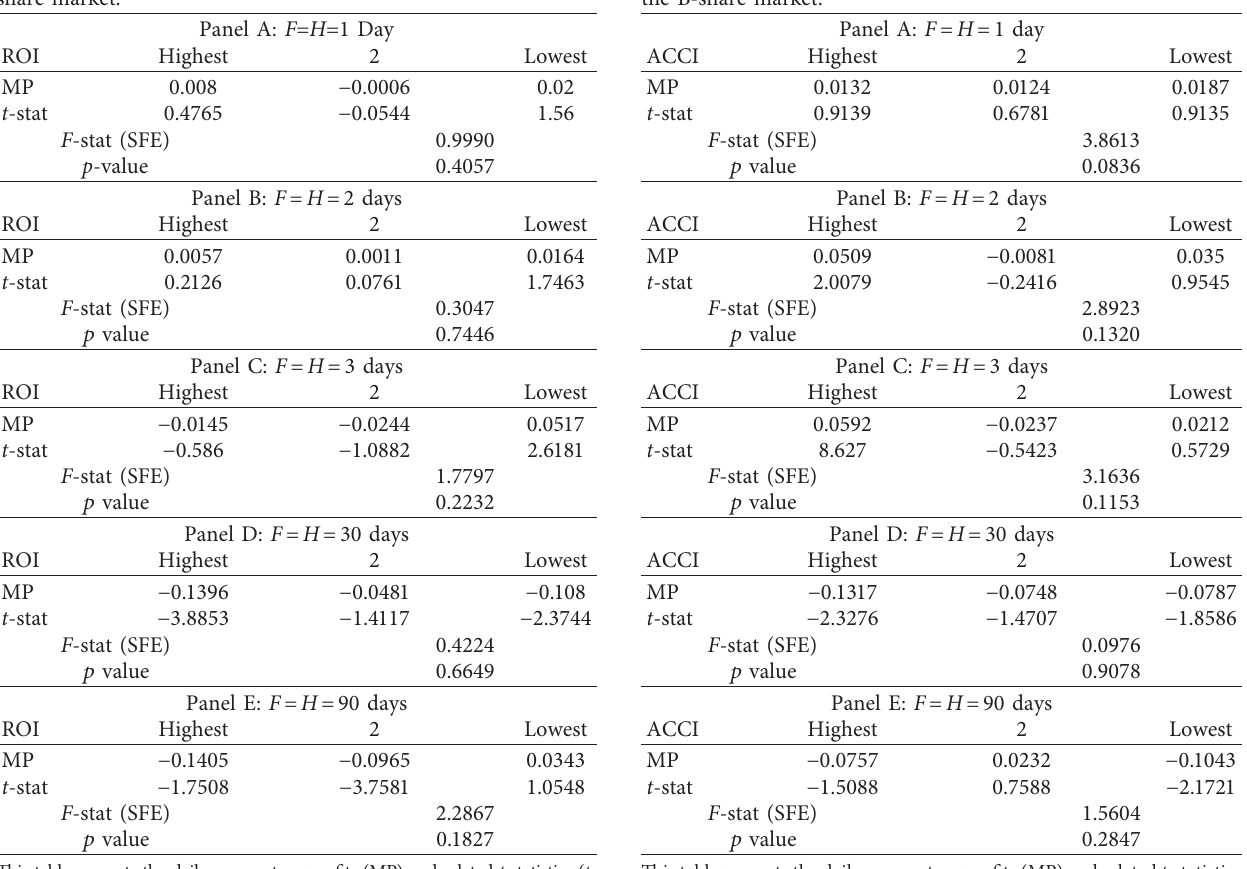
Table 6: The effect of the daily relative order imbalance of the B- share market.